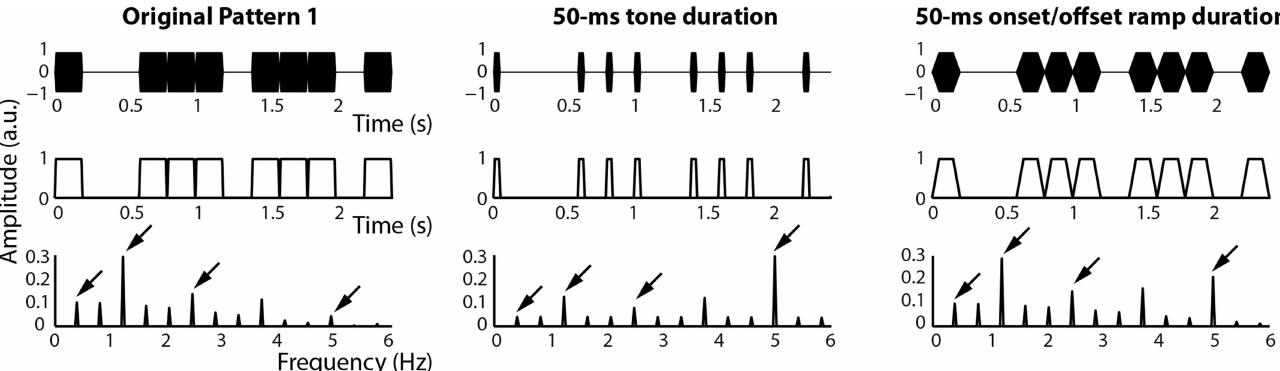
Fig 1. Examples of the acoustic manipulations applied to one representative rhythm analyzed in Experiment 1. The onset structure of the originalrhythm (left column) was preserved. Tone duration(middlecolumn) and onset/offset ramp duration (right column)were parametricallyvaried. After obtainingthe amplitudeenvelopes (middle row) of the stimulus waveforms (top row) via a Hilbert transform, the envelopes were transformed to the stimulus spectra in the frequency domainusing a FFT (bottom row). Arrows mark the beat-related frequencies0.416 Hz (1:12), 1.25 Hz (1:4), 2.5 Hz (1:2), and 5 Hz